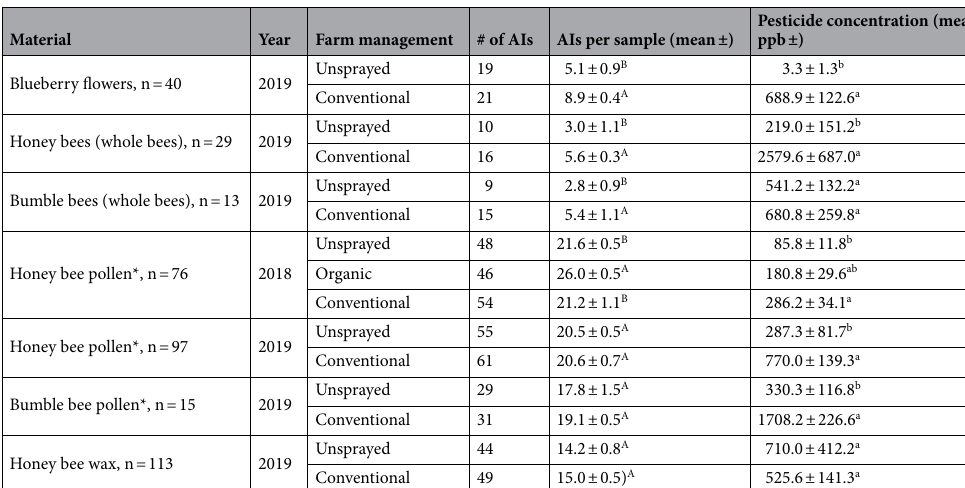
Table 1. Summary table of pesticide detections from pollen collected from honey bees or bumble bees, honey bee wax, whole bees collected from blueberry flowers, and blueberry flowers on blueberry farms in southwest Michigan. Number of active ingredients (AIs) detected includes all pesticides detected within a farm type (unsprayed, organic, or conventional) in each year. Superscript letters indicate significant differences within a year/bee combination. *Pollen data from Graham et al. 38